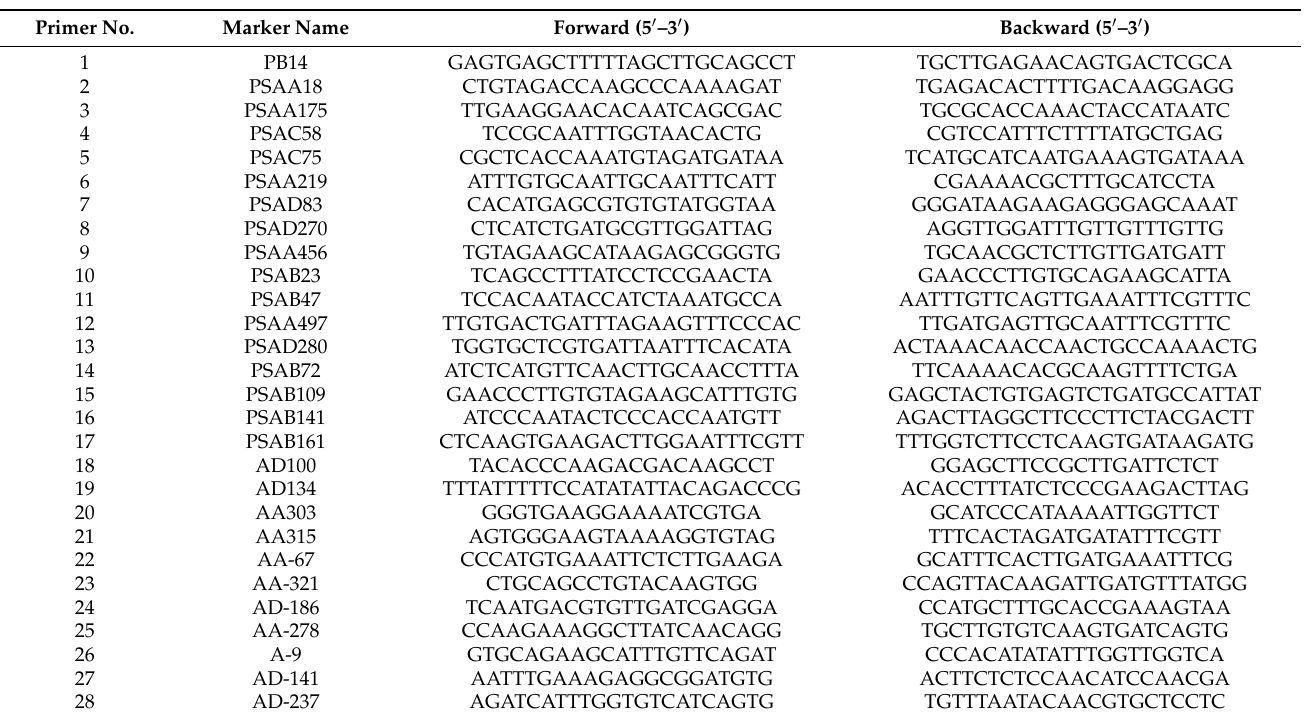
Table 2. Twenty-eight SSR primers for genetic diversity analysis among forage pea ( P. sativum ssp. arvense L.) landrace